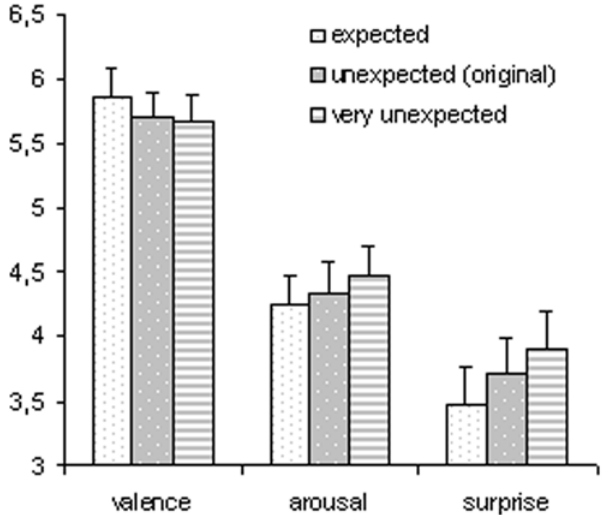
Figure 2. Average ratings of valence, arousal, and surprise, pooled for expressive and non-expressive excerpts (error bars indicate SEM, 1 corresponded to most unpleasant, least arousing, and least surprising, and 9 to most pleasant, most arousing, and most surprising). Ratings differed between the three chord types with regards to valence, arousal, and surprise (see text for details).